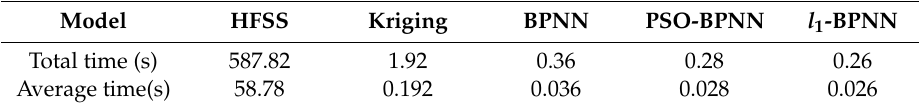
Figure 10. Comparison of actual versus predicted | S11 | values when using ( a ) l 1 -BPNN, ( b ) PSO-BPNN, ( c ) BPNN, ( d ) kriging surrogate models. Table 3. Computational Time of Various Surrogate Models and HFSS Simulations.